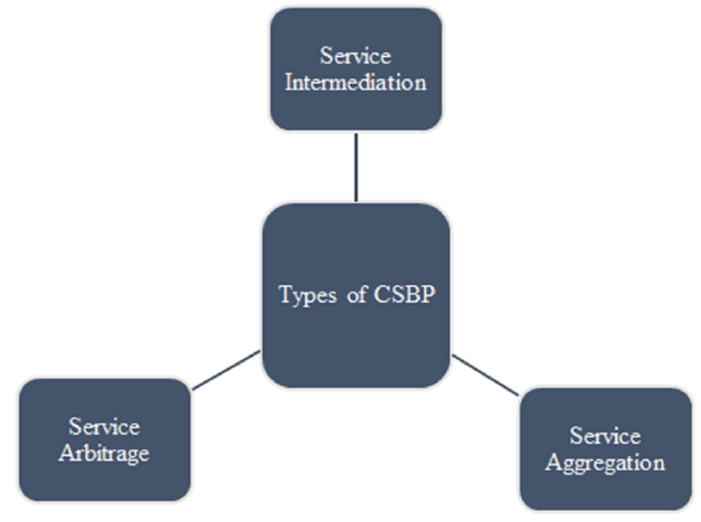
Figure 6. The cloud SBP services in three roles [11].